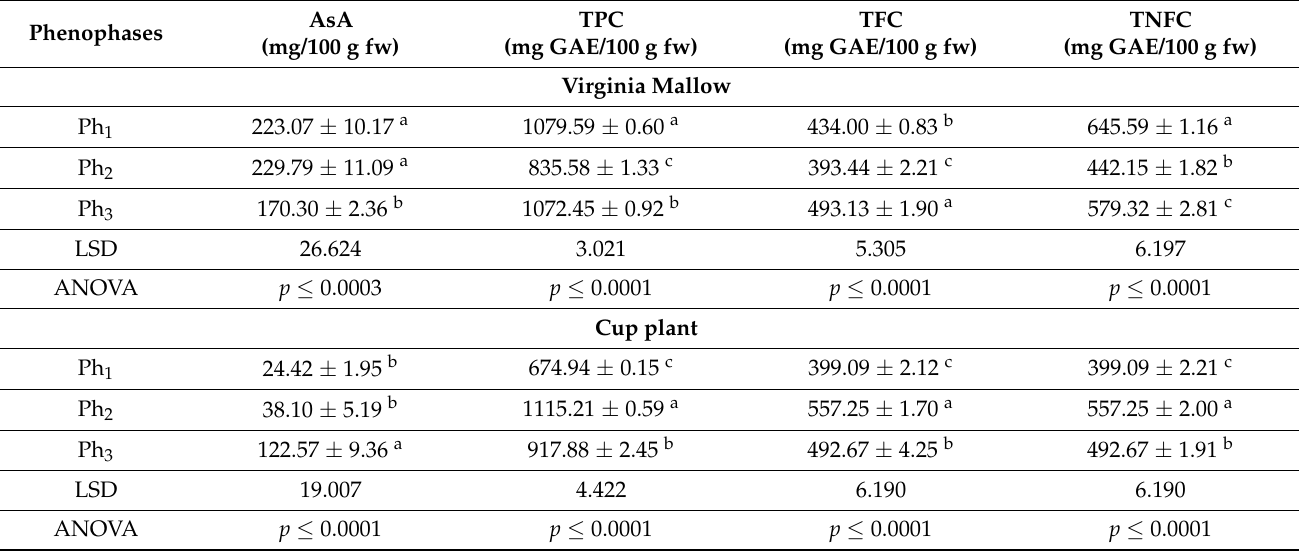
Table 3. Specialized metabolites content of Virginia mallow and cup plant leaves in differ- ent